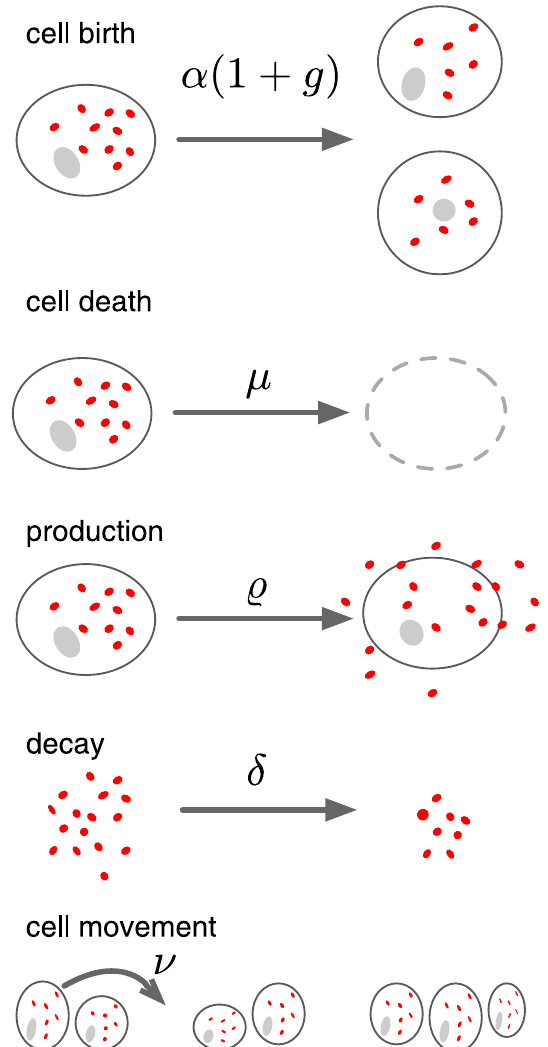
Fig 1. Overview of the mechanisms assumed in the model. Cancer cells divide at a rate α (1 + g ), where g is the local growth factor (GF) concentration, and die at a constant rate μ . The GF is produced at rate ρ by all cancer cells and decays at rate δ . Lastly, cells migrate at rate ν . Parameter values are provided in Table 1.